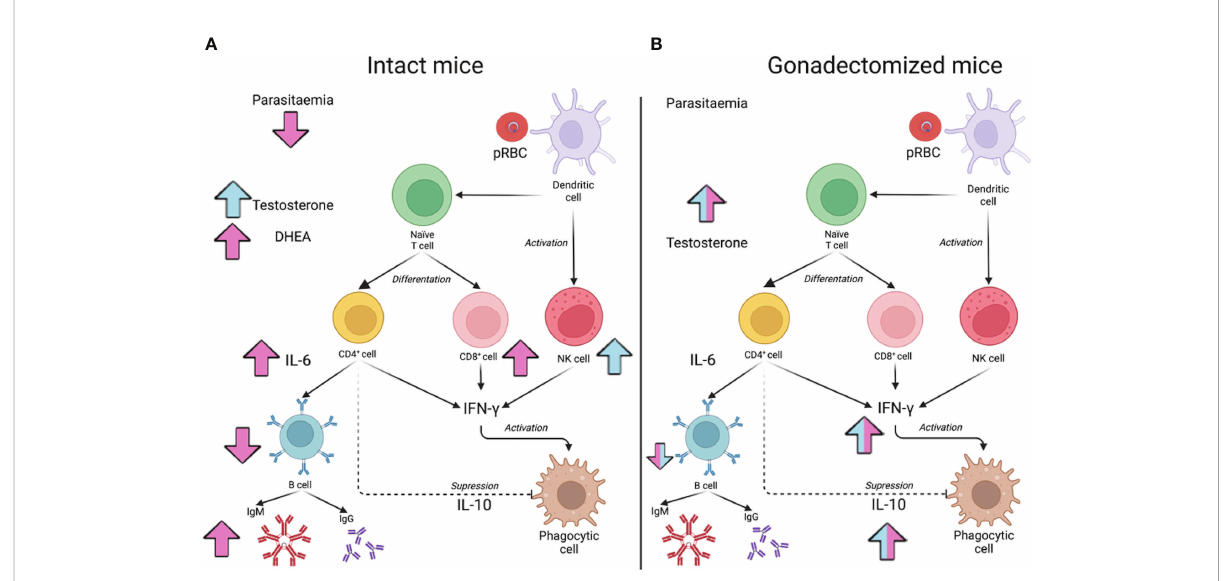
FIGURE 9 Model of testosterone involvement in sexual dimorphism of the immune response in malaria. The effect of testosterone administration on intact male or female mice is shown in (A) and reconstitution of gonadectomised male and female mice is shown in (B) . Pink arrows indicate the increase or decrease of the indicated variable in females, while in males, the effect of testosterone is indicated by blue arrows. In (A) , administering testosterone to intact males increased the concentration of free testosterone (Testosterone) and increased the percentage of NK cells in the spleen but did not signi fi cantly modify parasitaemia. In contrast, increasing testosterone concentration in females raised DHEA concentration, which promoted an increase in the number of CD8 + cells in the spleen; furthermore, it increased serum IL-6 concentration, which, in turn, could boost the maturation of B cells (B220 + ) to IgM-producing plasma cells. In contrast, increasing testosterone concentration in females increased DHEA levels, which promoted a rise in the number of CD8 + cells in the spleen; furthermore, it increased serum IL-6 concentration, which, in turn, could boost the maturation of B cells to IgM-producing plasma cells. However, as these cells mature, they lose their surface marker, so their number in the spleen decreases. These results would explain why parasitaemia in females was reduced. In (B) , the effect of testosterone reconstitution in gonadectomised mice is shown. When the effect is the same in both sexes, the arrows are bicoloured (pink and blue). Reconstituting gonadectomised mice with testosterone increased the concentration of free testosterone, and this decreased the number of B220 + cells and increased the concentration of IL-10, which probably reduced the IFN- g -mediated proin fl ammatory response and, therefore, no effects on parasitaemia were